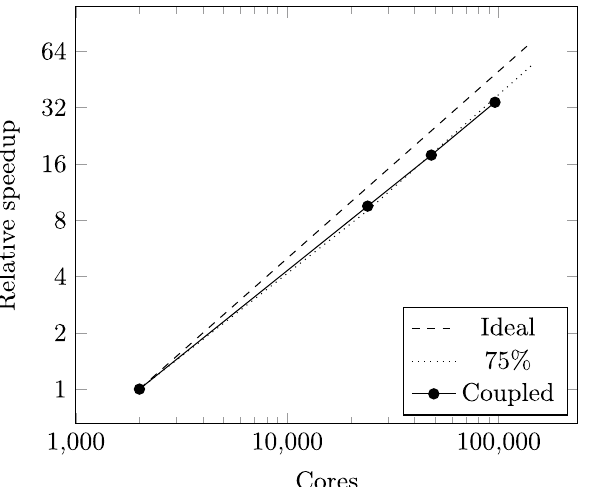
Figure 7. Strong scaling performance of the self-coupled HemeLB implementation described in McCullough et al. 16 to 96,000 cores of SuperMUC-NG. Ideal and 75% scaling lines are provided as a guide. The coupled simulation transferred data between simulations every 500 steps.